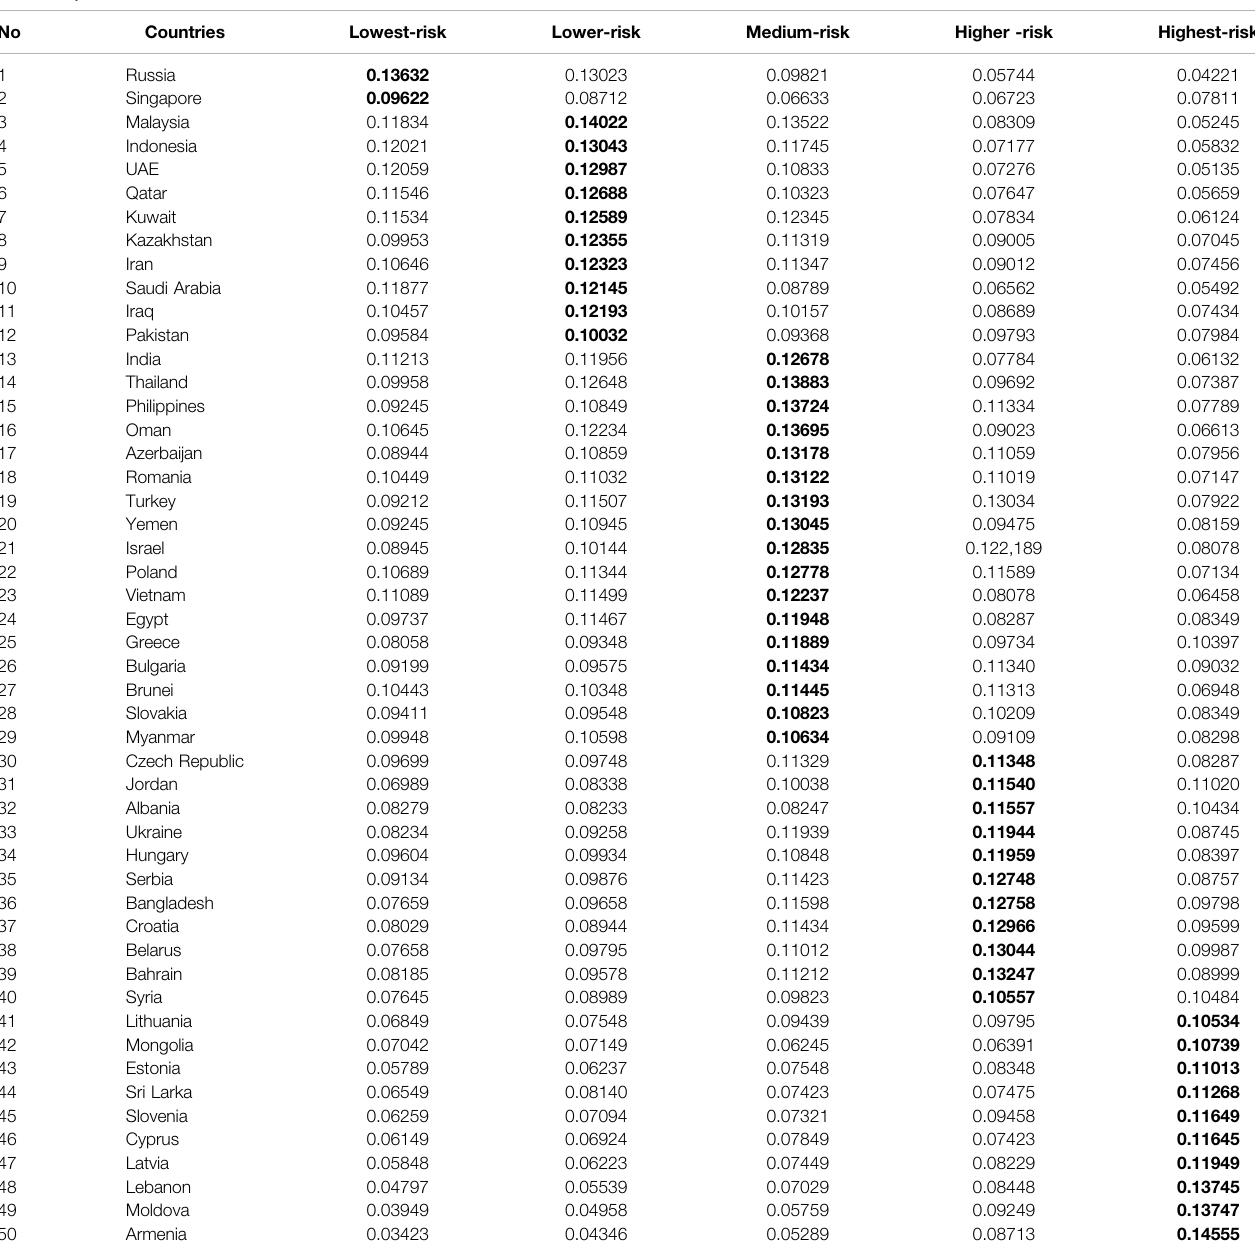
TABLE 4 | Evaluation